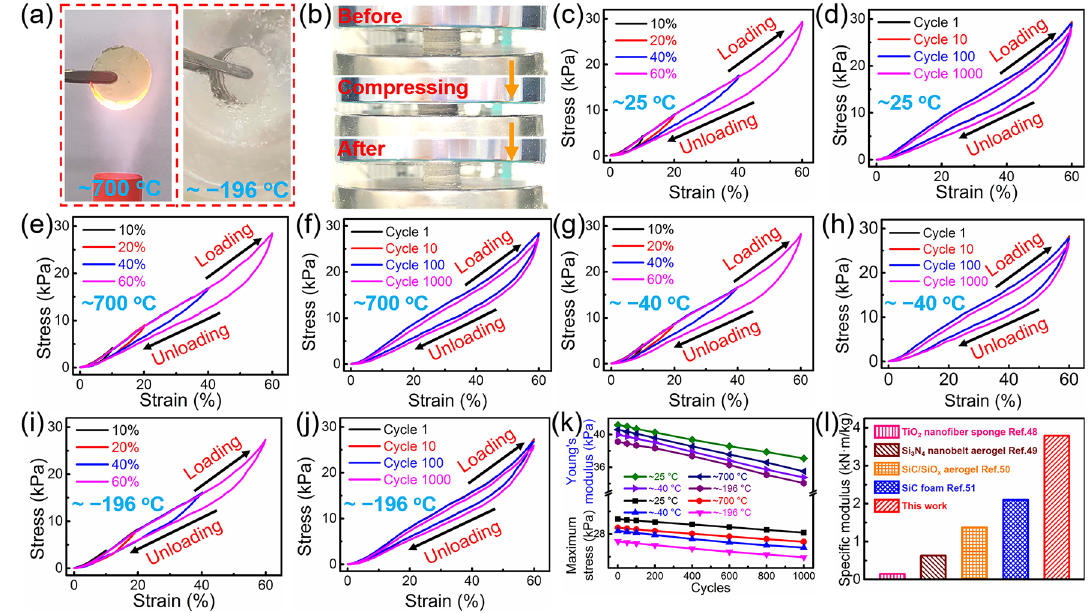
Fig. 4 Temperature-invariance hyperelasticity of the SiC@SiO 2 NFA. a The SiC@SiO 2 NFA placed inside the flame of an alcohol blowtorch (~ 700 °C) and immersed in liquid nitrogen (~ − 196 °C). b Compression test for the SiC@SiO 2 NFA, which can quickly recover to its original shape. Compression stress–strain curves for the SiC@SiO 2 NFA at c ~ 25 °C, e ~ 700 °C, g ~ − 40 °C and i ~ − 196 °C. Cyclic compression stress–strain curves for the